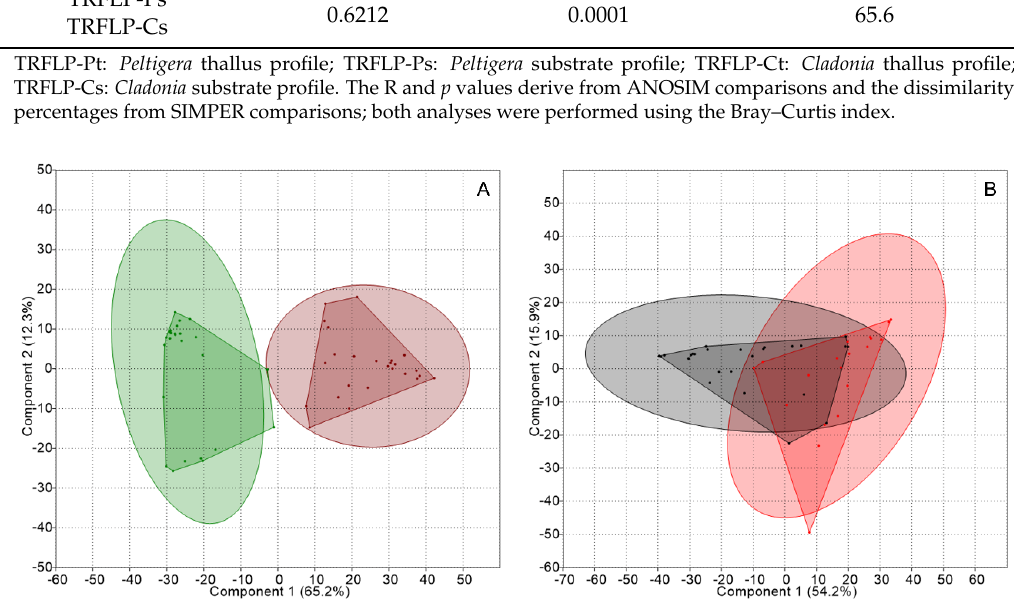
Figure 1. Principal component analyses (PCA) of the genetic structure of the nitrogen-fixing guild associated with thalli and substrates from each lichen genus: ( A ) Peltigera thalli (green) and substrates (brown), and ( B ) Cladonia thalli (red) and substrates (gray). Concentration ellipses (ovals surrounding the convex hulls) estimate the region where 95% of population points are expected to fall.